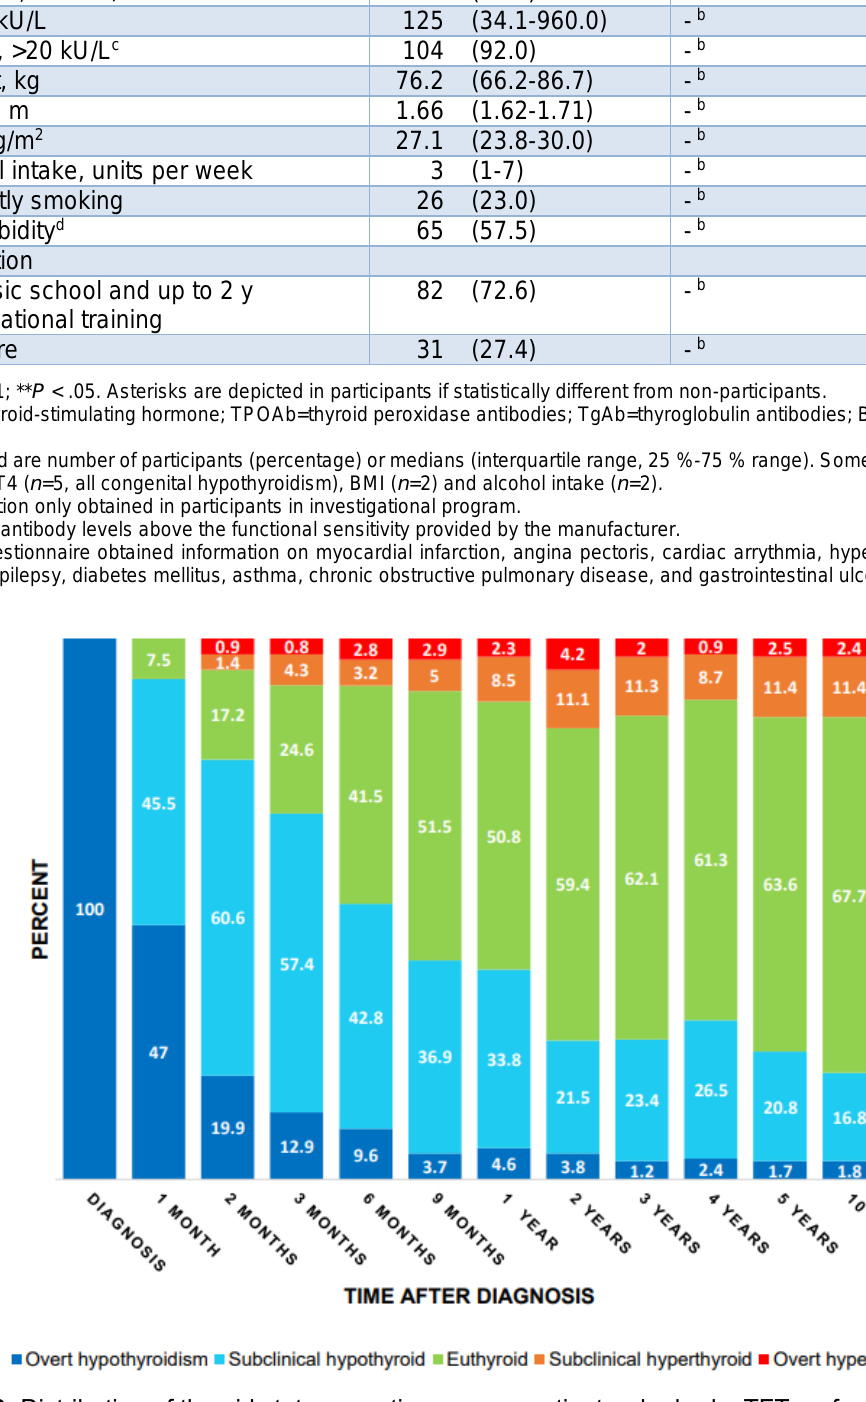
Figure 2: Distribution of thyroid status over time among patients who had a TFT performed within each of the time